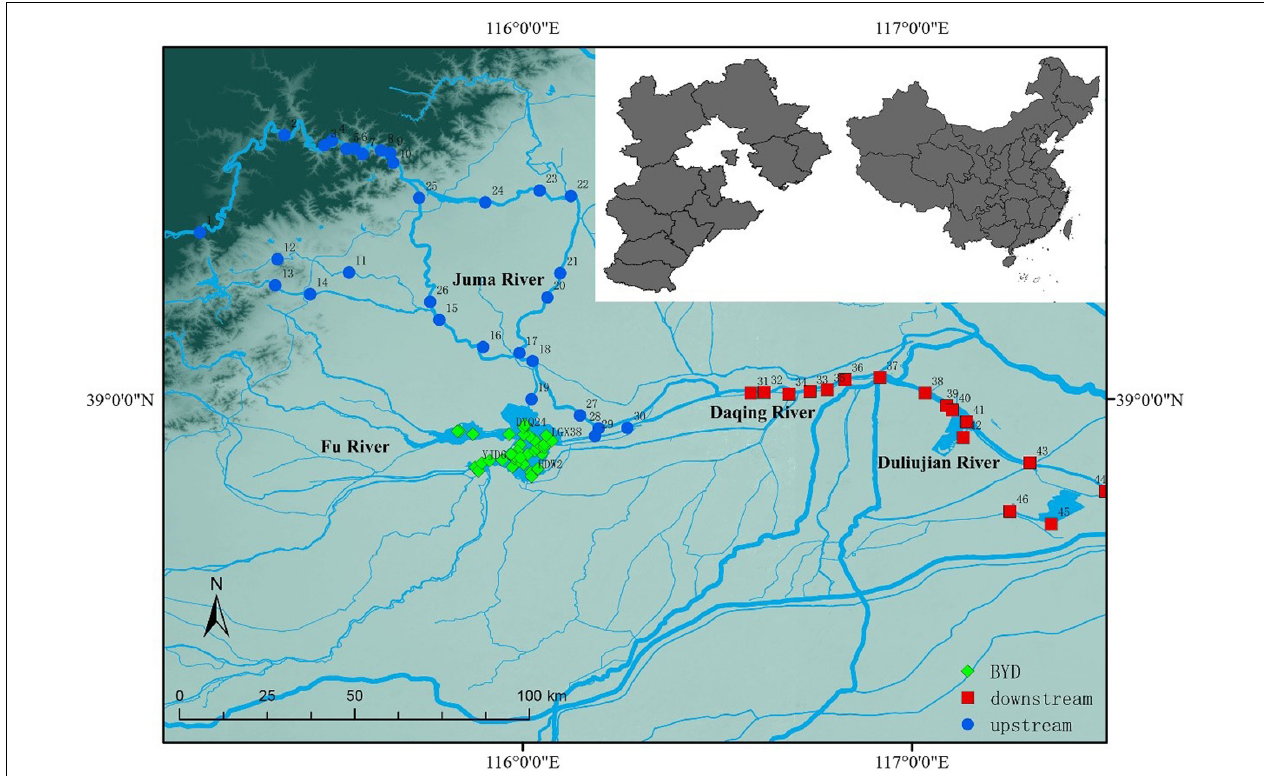
FIGURE 1 | The distributions of 82 sampling sites located in the BYD Basin, northern China. The different shapes and colors in the figure represent different freshwater areas. Blue: upstream; green: BYD; red: